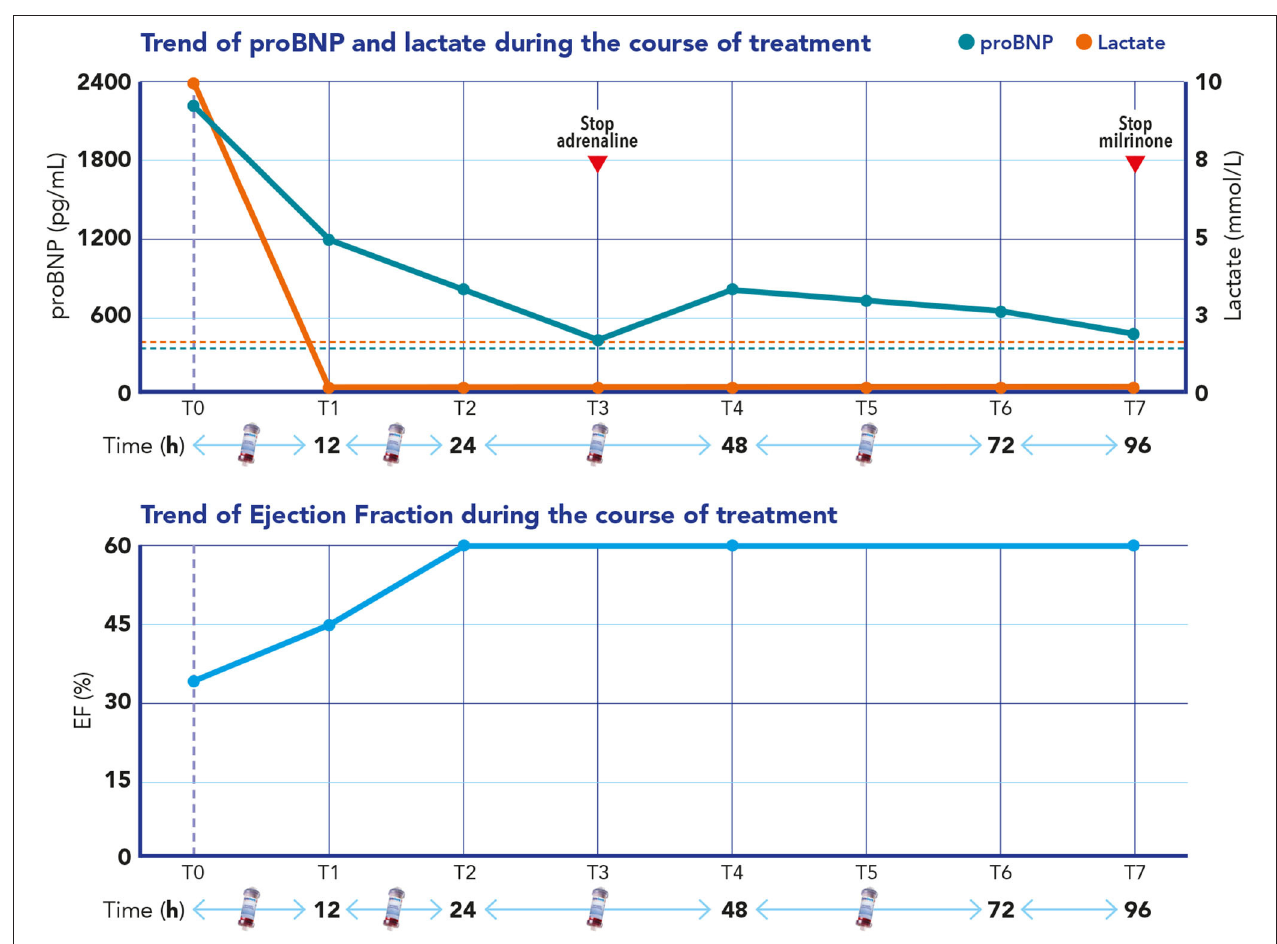
FIGURE 1 | Upper section: Time course of B-type natriuretic peptide (pro-BNP) and lactate during extracorporeal blood purification treatment (EBPT). Blue dashed line refers to the normal value of pro-BNP ( < 360 pg/ml); red dashed line refers to the normal value of lactate ( < 2 mmol/L). Lower section: Time course of the ejection fraction during EBPT and in the following days after stopping adrenaline, milrinone, and